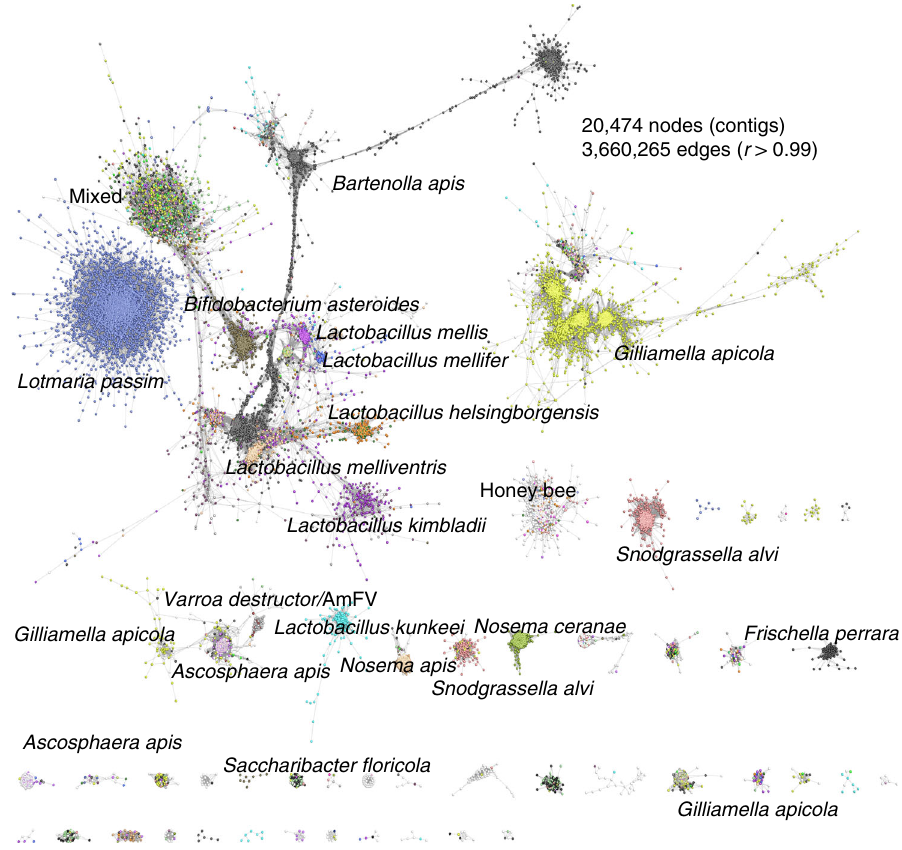
Fig. 3 Correlation network analysis of microbiome contigs. Each node represents an individual contig and edges are de fi ned based on the correlation between abundance pro fi les (base coverage) across individual samples. Contigs (nodes) are connected if the Pearson correlation between two contigs abundance pro fi le was r > 0.99. Each contig is coloured according to the species it maps to, white nodes represent contigs for which no signi fi cant sequence match was